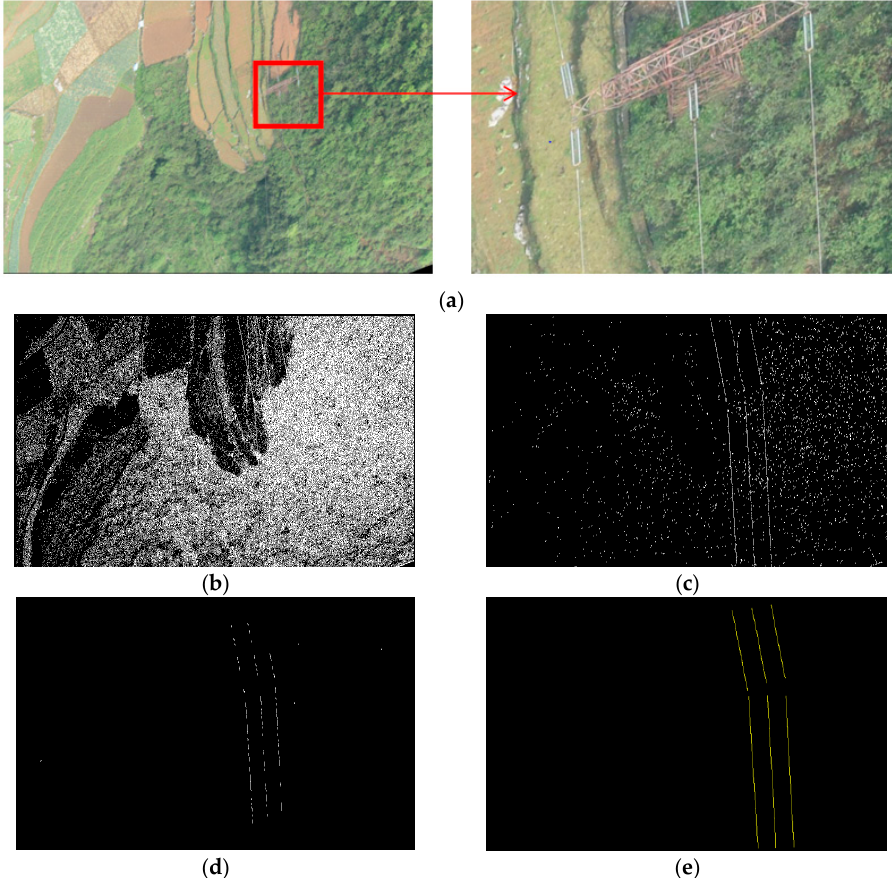
Figure 5. Visualization of power line extraction. ( a ) Left epipolar image of a stereo; ( b ) Result of power line feature detection using a gray ratio operator; ( c ) Result of the refinement of power line features using mathematical morphology; ( d ) Result of the refinement of power line features using the equivalent line condition; ( e ) Result of power line 2D vector extraction by prior knowledge.